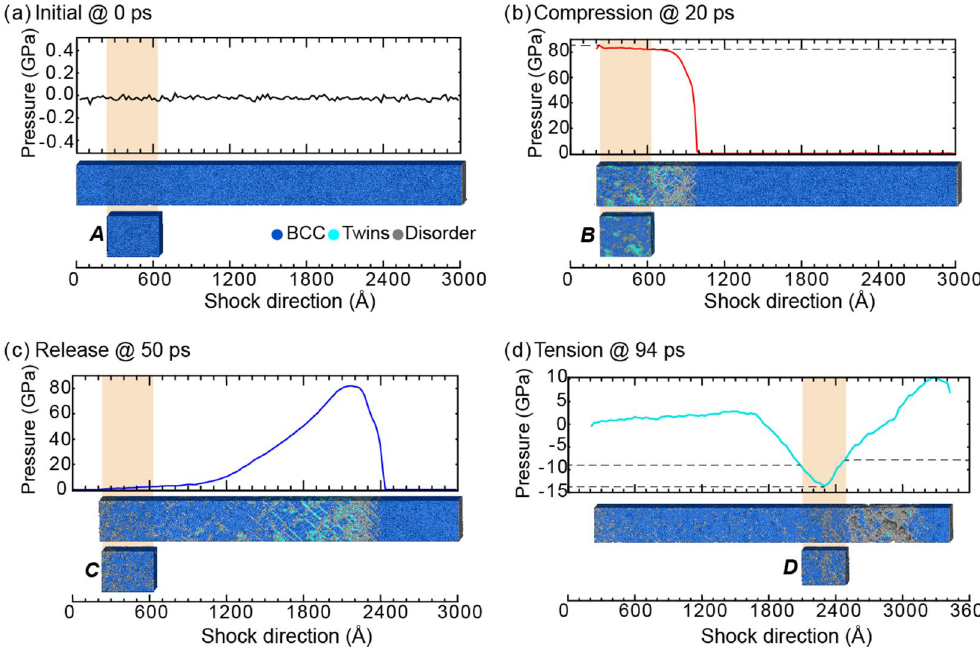
Figure 2. The pressure distribution and microstructure for select time steps of shocked Ta. Cropped regions to be assessed with virtual diffraction are highlighted in tan. The cropped regions, labeled A–D, correspond to the blue rectangles in Fig.